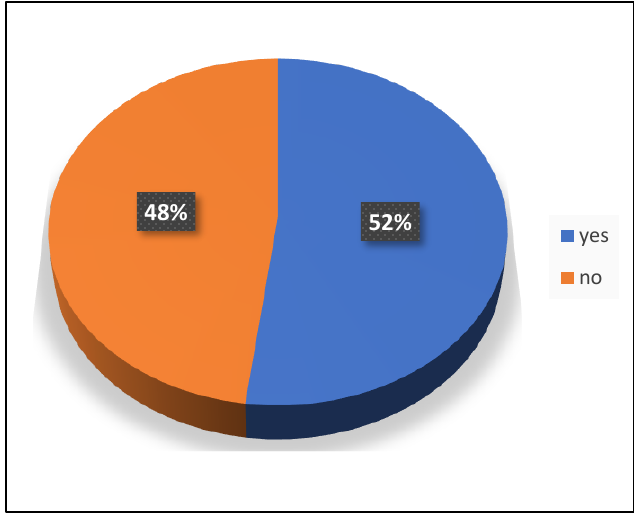
Fig. 8. Awareness of policies